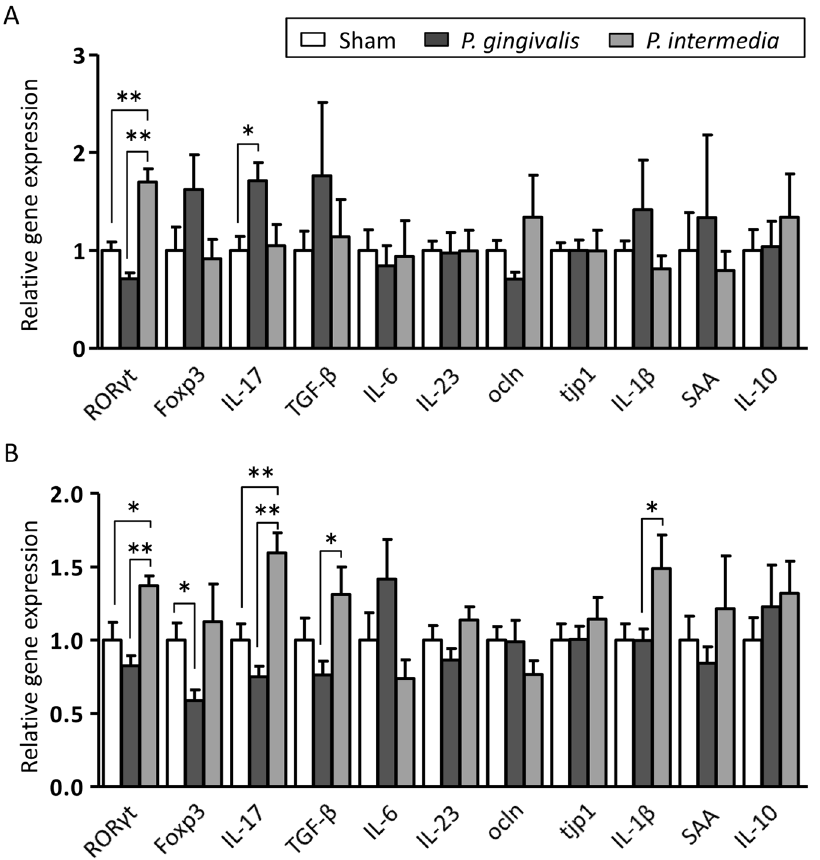
Figure 6. Effect of P. gingivalis and P. intermedia administration on gene expression of the gut. ( A ) Relative gene expression levels in the small intestines of sham-, P. gingivalis -, and P. intermedia -administered mice (N = 7 in each group). ( B ) Relative gene expression levels in the large intestines of sham-, P. gingivalis -, and P. intermedia - administered mice (N = 7 in each group). Relative mRNA expression levels of genes were normalised to the relative quantity of glyceraldehyde-3-phosphate dehydrogenase mRNA. Data represent the mean ± SEM (N = 7). * p < 0.05, ** p < 0.01, One-way ANOVA with Bonferroni corrections for multiple